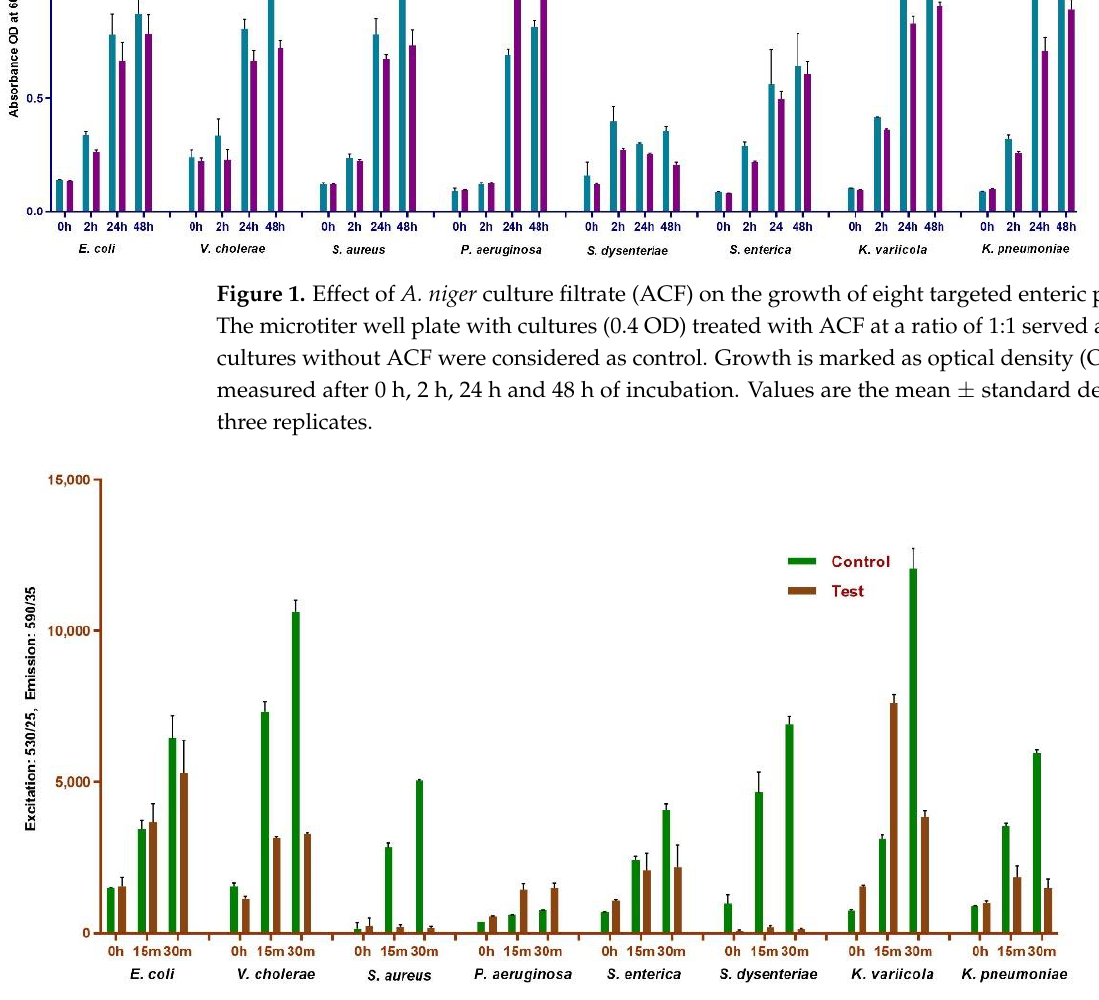
Figure 2. Effect of ACF on the viability of eight targeted micro-organisms by resazurin cell viability assay. The 96 well plate having cultures (0.4 OD) treated with ACF at a ratio of 1:1 served as a test. The cultures without ACF were considered as control. Both test and control were treated with resazurin (1 mmol) and the viability was measured at excitation and emission wavelength of 530/25, 590/35 respectively at an interval of 15 min. Values are means ± standard deviation of three repli- cates.